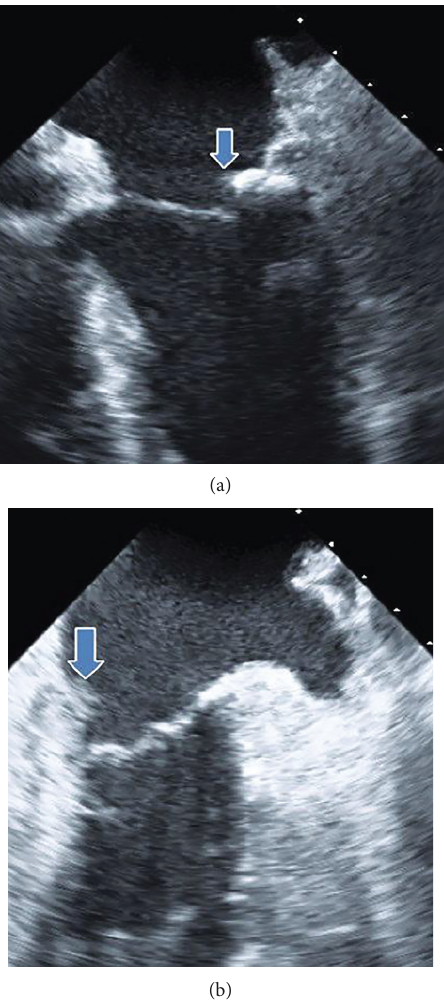
Figure 3: (a) PET/CT scan showing slightly increased 18F FDG uptake of the spleen performed during the antibiotic therapy in- dicates inflammation. (b) PET/CT scan showing splenic in- flammation as well as splenic